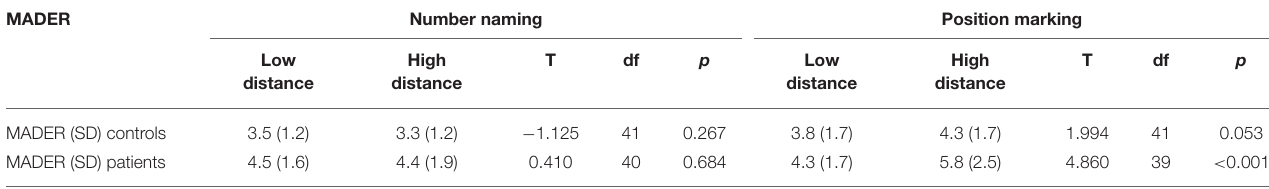
TABLE 3 | MADER and dependent t-statistics for low- and high-distance stimuli of the number line estimation tasks for chronic pain patients and controls. MADER